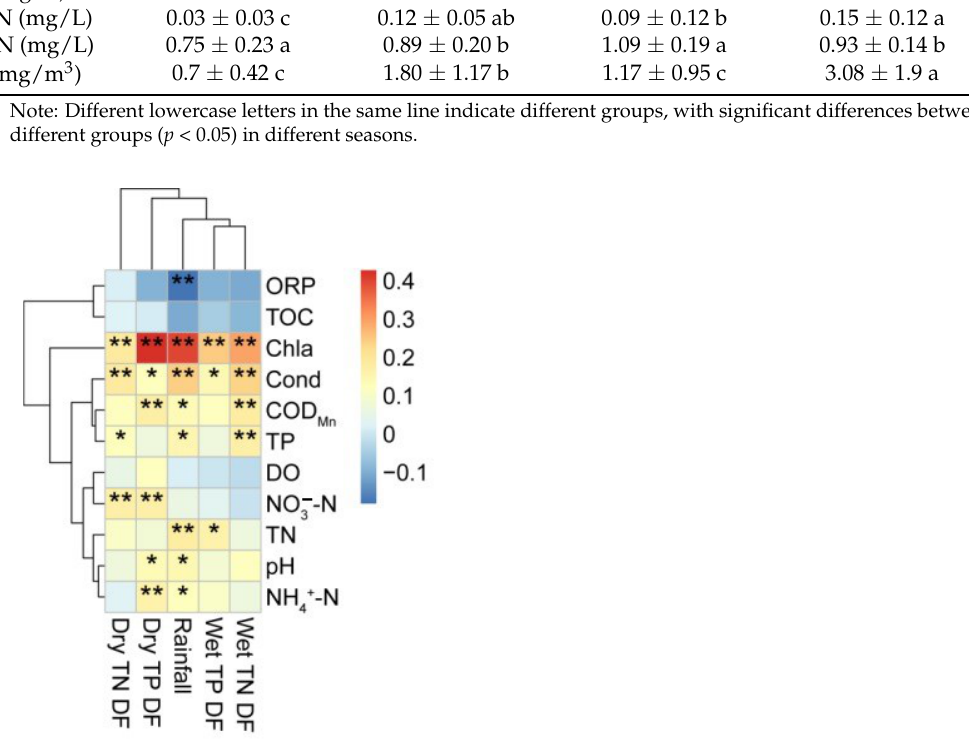
Figure 4. Relationship between atmospheric nitrogen and phosphorus deposition fluxes and rainfall and water quality factors. * means p < 0.05, ** means p < 0.01.